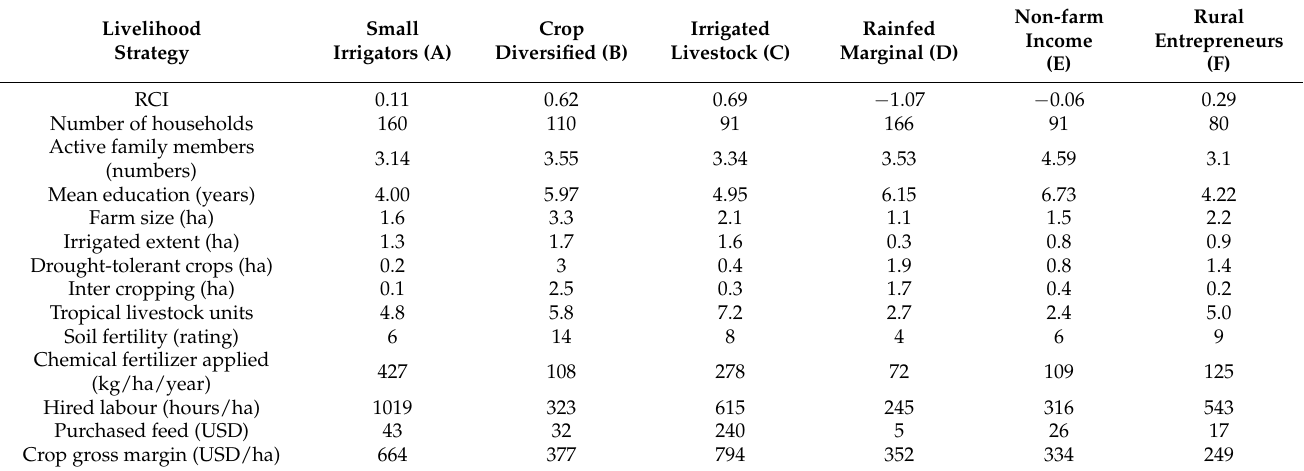
Table 4. Household characteristics by livelihood strategy (Mean).